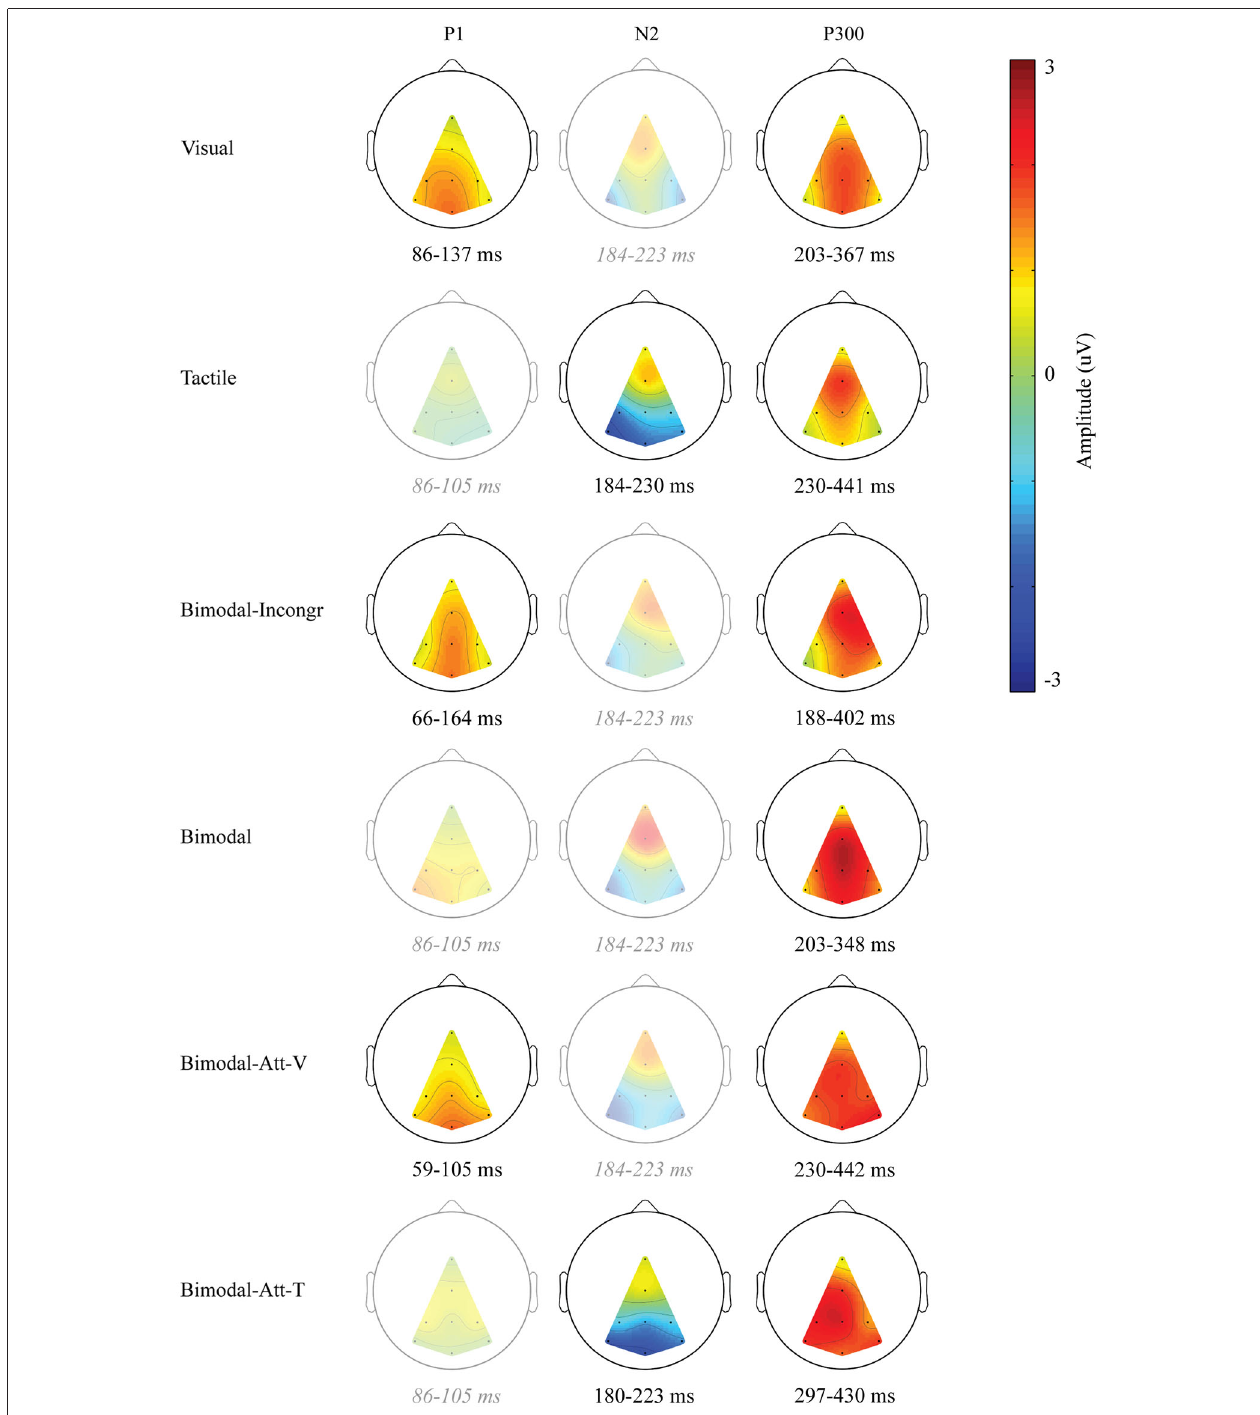
identified, the overlapping interval (of the windows of the ERP component for conditions in which it was identified) was used to visualize that activity for comparison. In that case, the scalp plot is left semitransparent, and the corresponding interval is shown in gray and